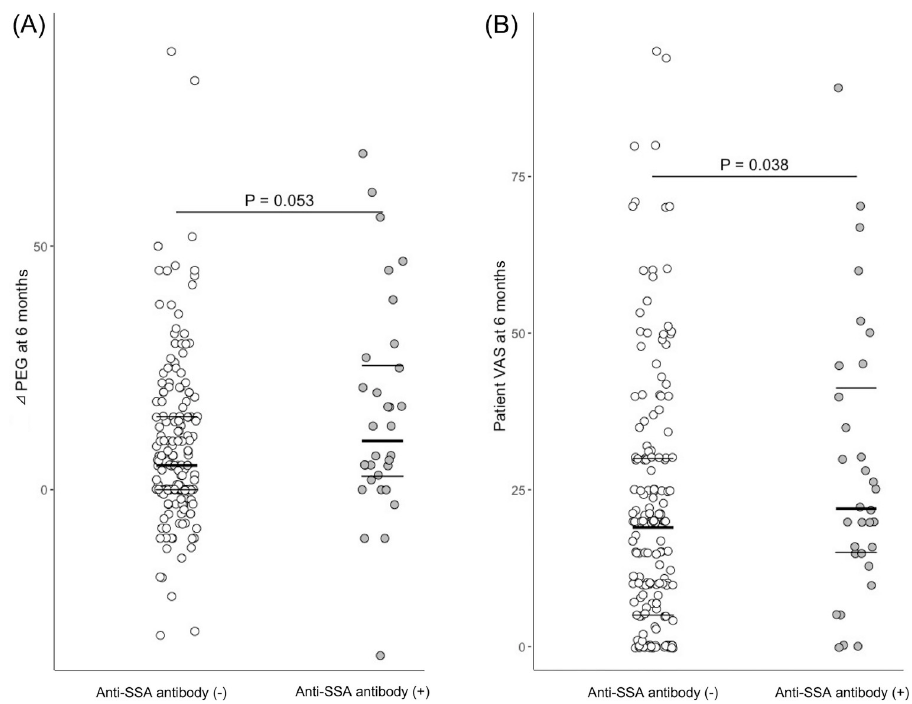
Fig 1. Δ PEG (A) and patient VAS score (B) after 6 months of MTX administration in the anti-SSA antibody-positive and -negative groups. Horizontal lines represent the median, 1 st quartile, and 3 rd quartile. Δ PEG, numeric difference between patient VAS score and physician VAS score; VAS, visual analogue